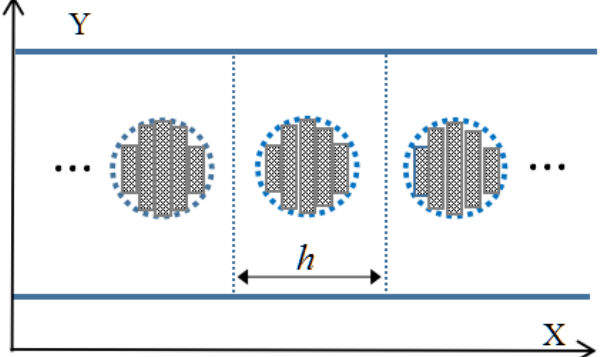
Figure 2. Discretization of circular rods by a sufficient number of thin, parallel rectangular rods.